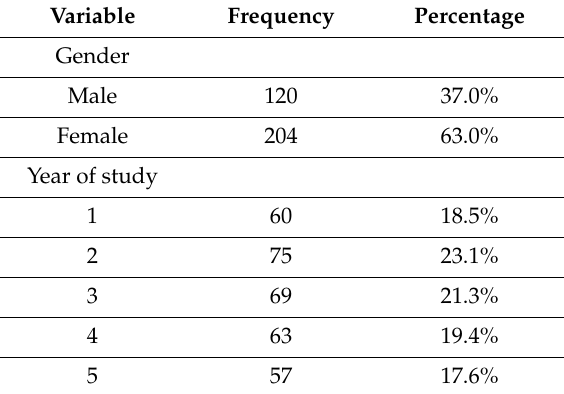
Table 1. Demographic characteristics of the respondents.